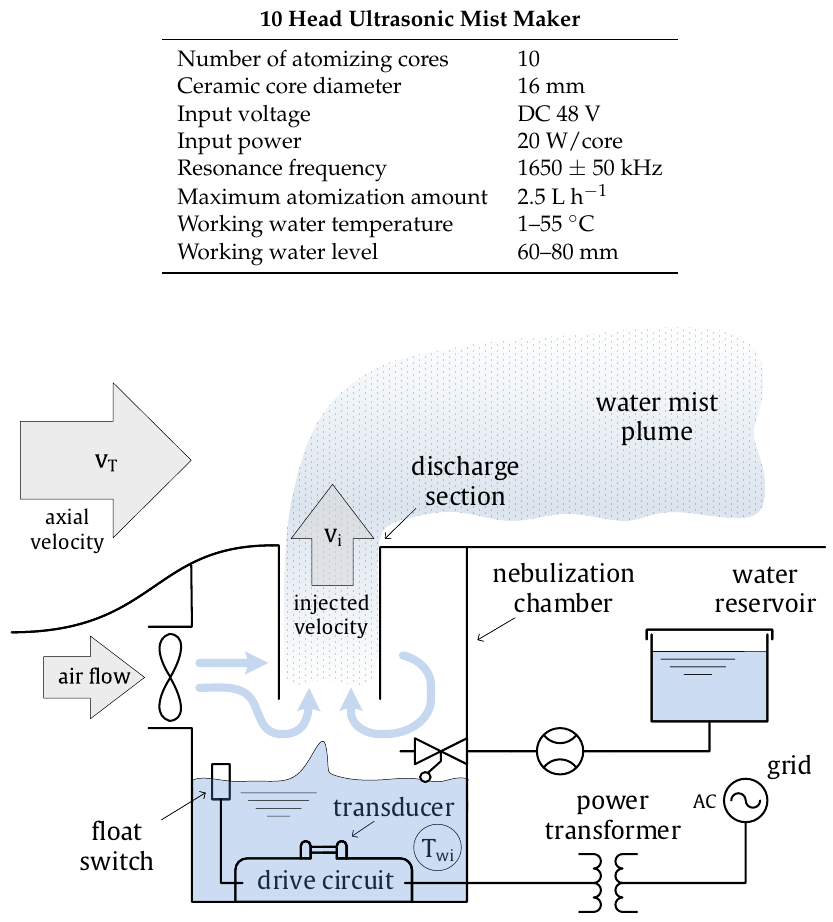
Figure 1. Schematic view of the principal components that make up the ultrasonic mist generator and layout of the two flows considered in the numerical